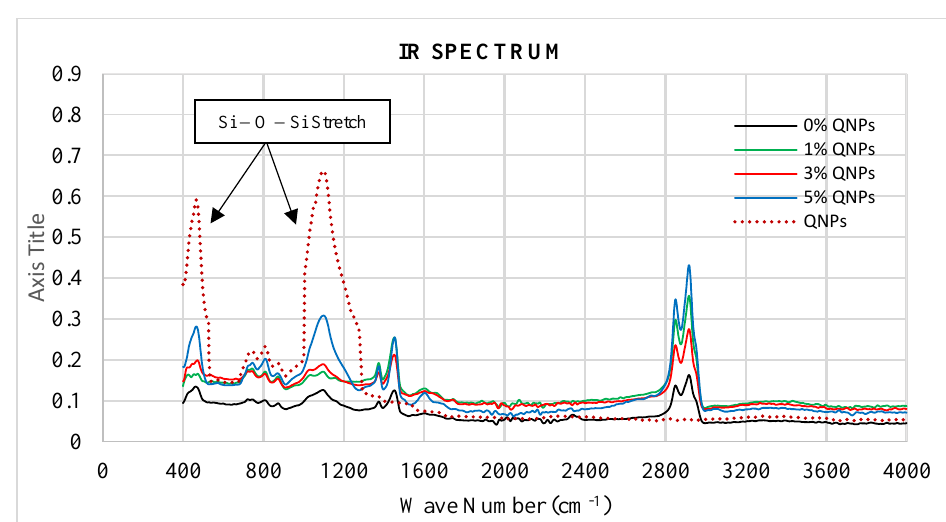
Figure 6. IR spectrum.